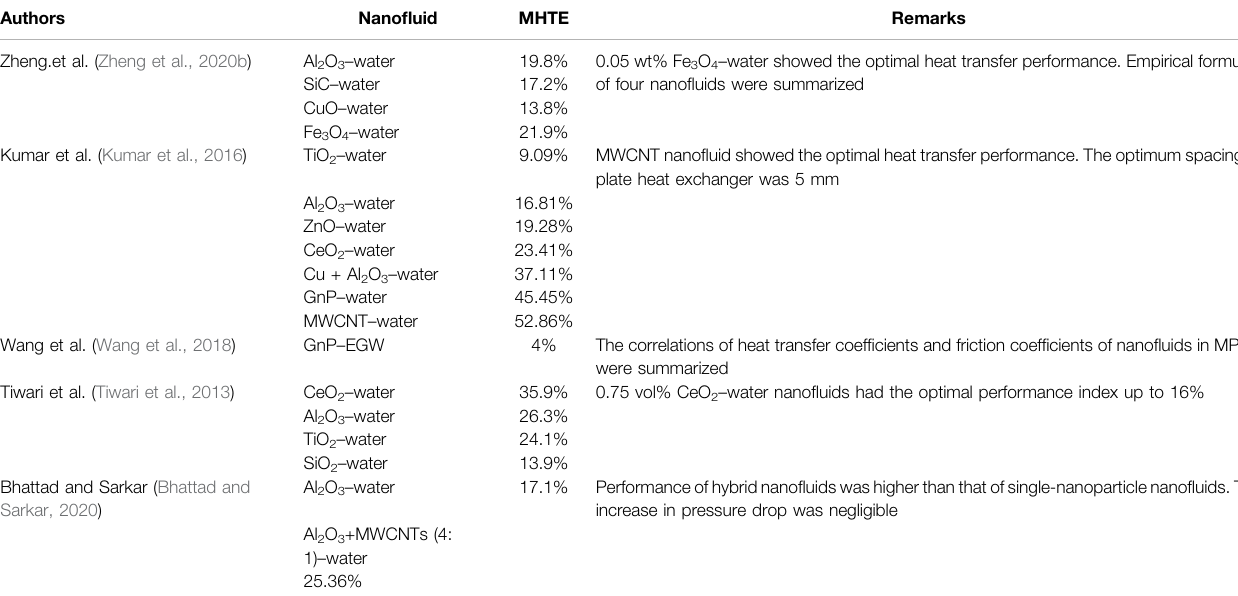
TABLE 9 | Thermal performance of nano fl uids in plate heat exchangers.